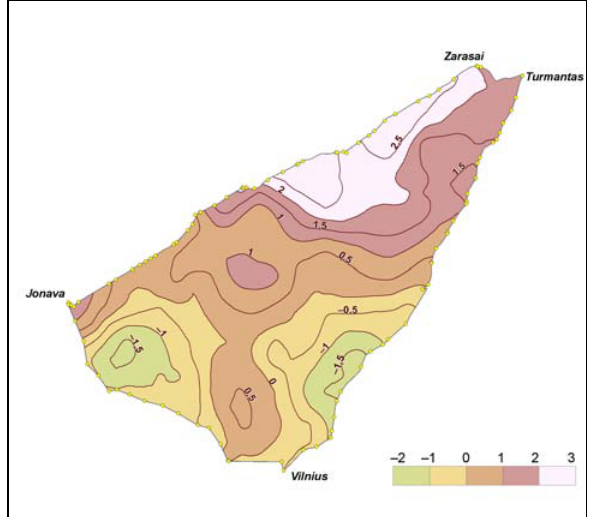
7 pav. Pagal (19) regresin į model į prognozuotas dabartinis tektoninis fonas (judesi ų grei č iai mm per metus) Fig 7. The present tectonic background (movements mm per year) according to the regression model